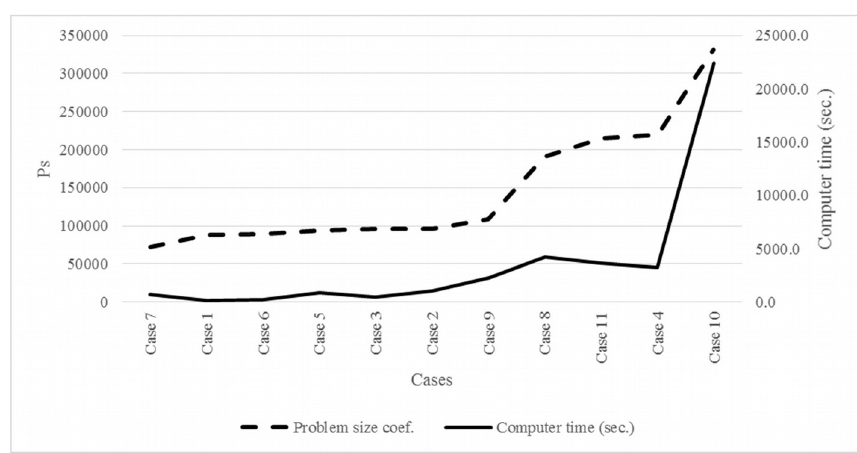
Figure 2. Run time performance of Model-A respect to P